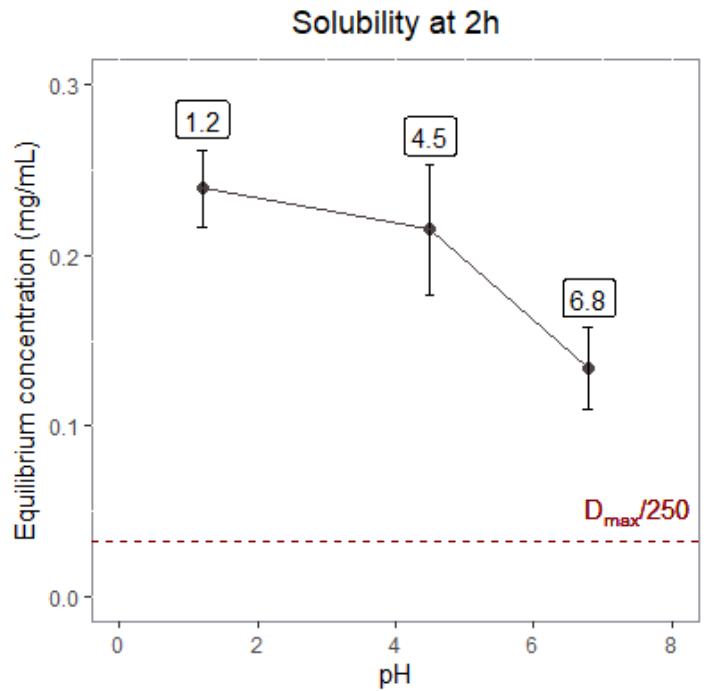
Figure 2. Equilibrium concentrations of silodosin at pHs 1.2, 4.5, and 6.8 after 2 h.